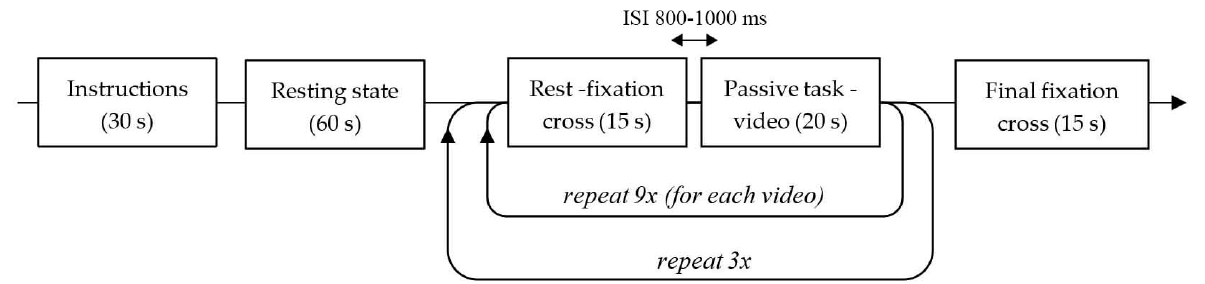
Figure 1. T1 and T2 brain imaging protocol.